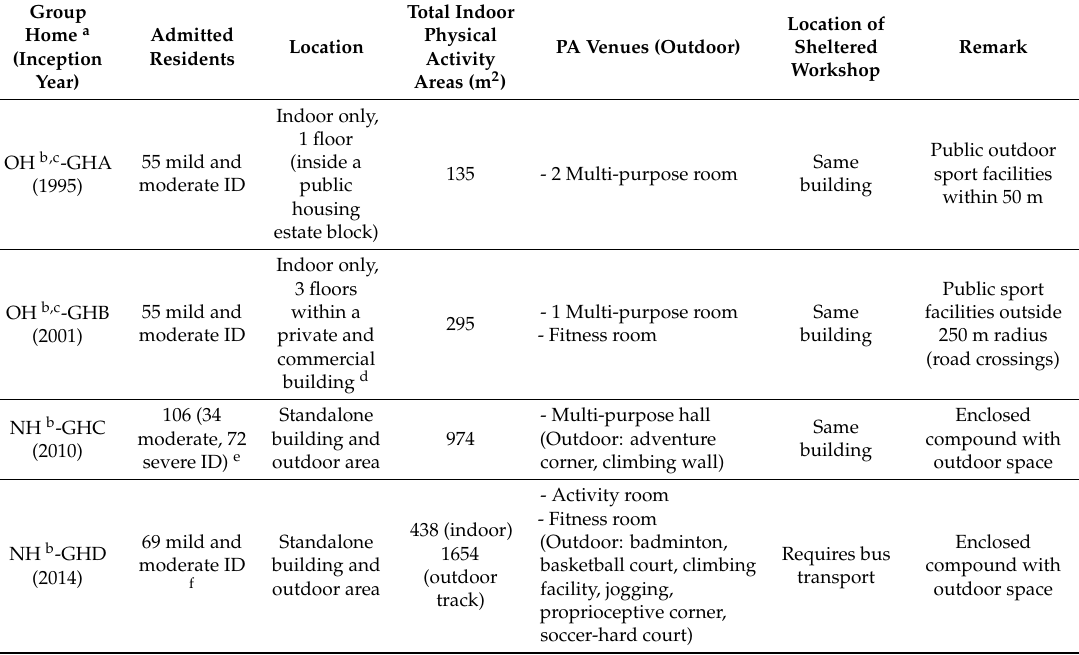
Table 1. Characteristics of four group homes for people with mild and moderate intellectual disabilities